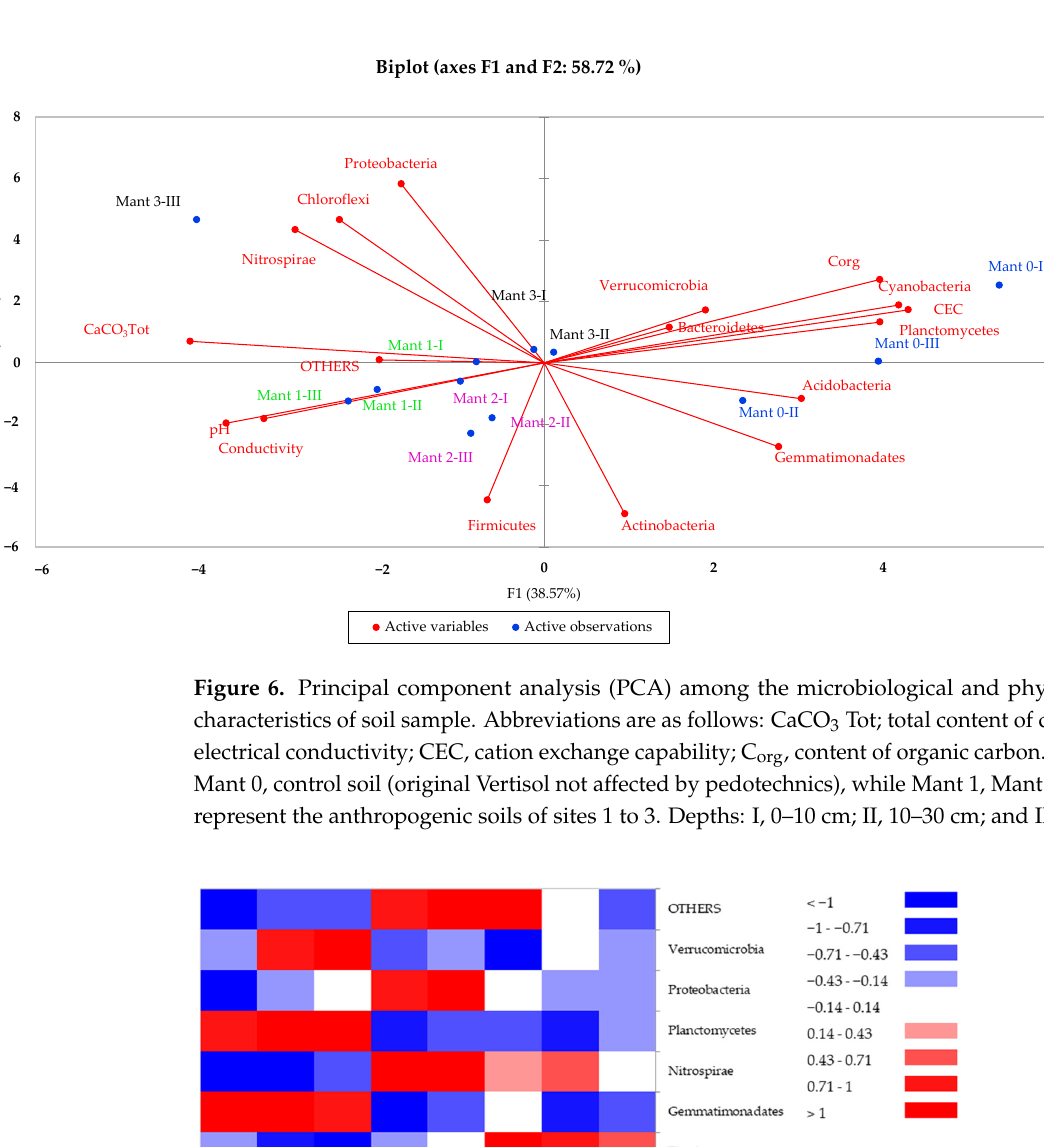
Figure 6. Principal component analysis (PCA) among the microbiological and physicochemical characteristics of soil sample. Abbreviations are as follows: CaCO 3 Tot; total content of carbonate; EC, electrical conductivity; CEC, cation exchange capability; C org , content of organic carbon. Soil samples: Mant 0, control soil (original Vertisol not affected by pedotechnics), while Mant 1, Mant 2 and Mant 3 represent the anthropogenic soils of sites 1 to 3. Depths: I, 0–10 cm; II, 10–30 cm; and III, 30–50 cm.